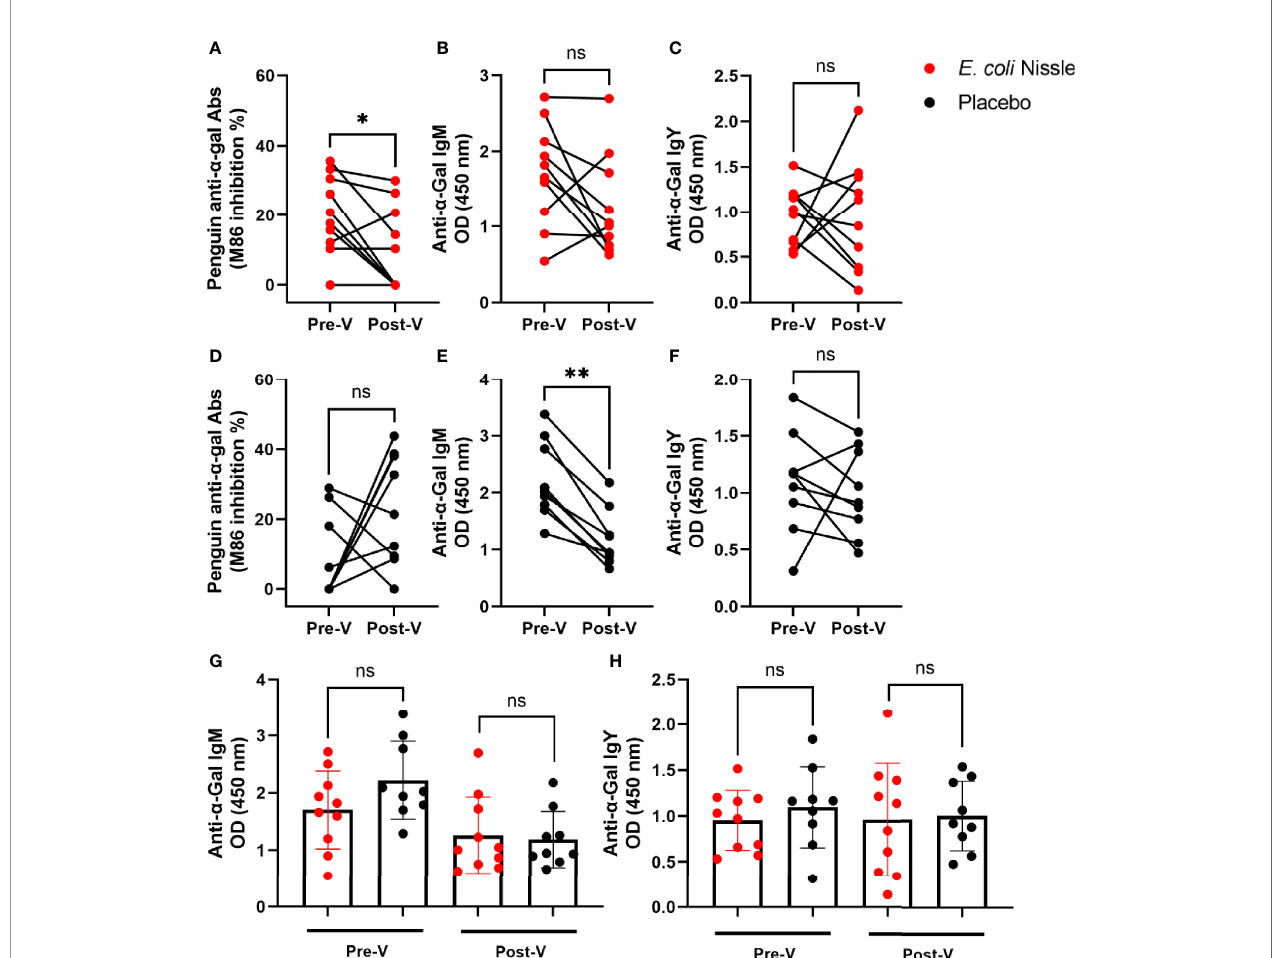
FIGURE 3 | Variation in penguin anti- a -Gal Ab levels after oral administration of E coli Nissle. The levels of circulating total anti- a -Gal Ab (A) and anti- a -Gal IgM (B) and IgY (C) were measured by competitive (A, D) and indirect (B, C , E, F – H) ELISA in the E coli Nissle (red dots) and placebo (black dots) groups before (Pre-V) and after (Post-V) the vaccination protocol. Total anti- a -Gal Abs decreased in the sera of penguins vaccinated with oral E coli Nissle (A) . Anti- a -Gal IgM decreased in the sera of penguins of the placebo group (E) . No signi fi cant differences were observed in the levels of anti- a -Gal IgM (G) and IgY (H) when the two groups, E coli Nissle and placebo, were compared Pre-V and Post-V. Individual (A – F) and means and standard deviation (G, H) values are shown. Values were compared by paired (A – F) or unpaired (G, H) student ’ s t -test (* p < 0.05, ** p < 0.005; ns, not signi fi cant, 1 experiment, n = 10 in the E coli Nissle group and n = 9 in the placebo group, and three technical replicates per